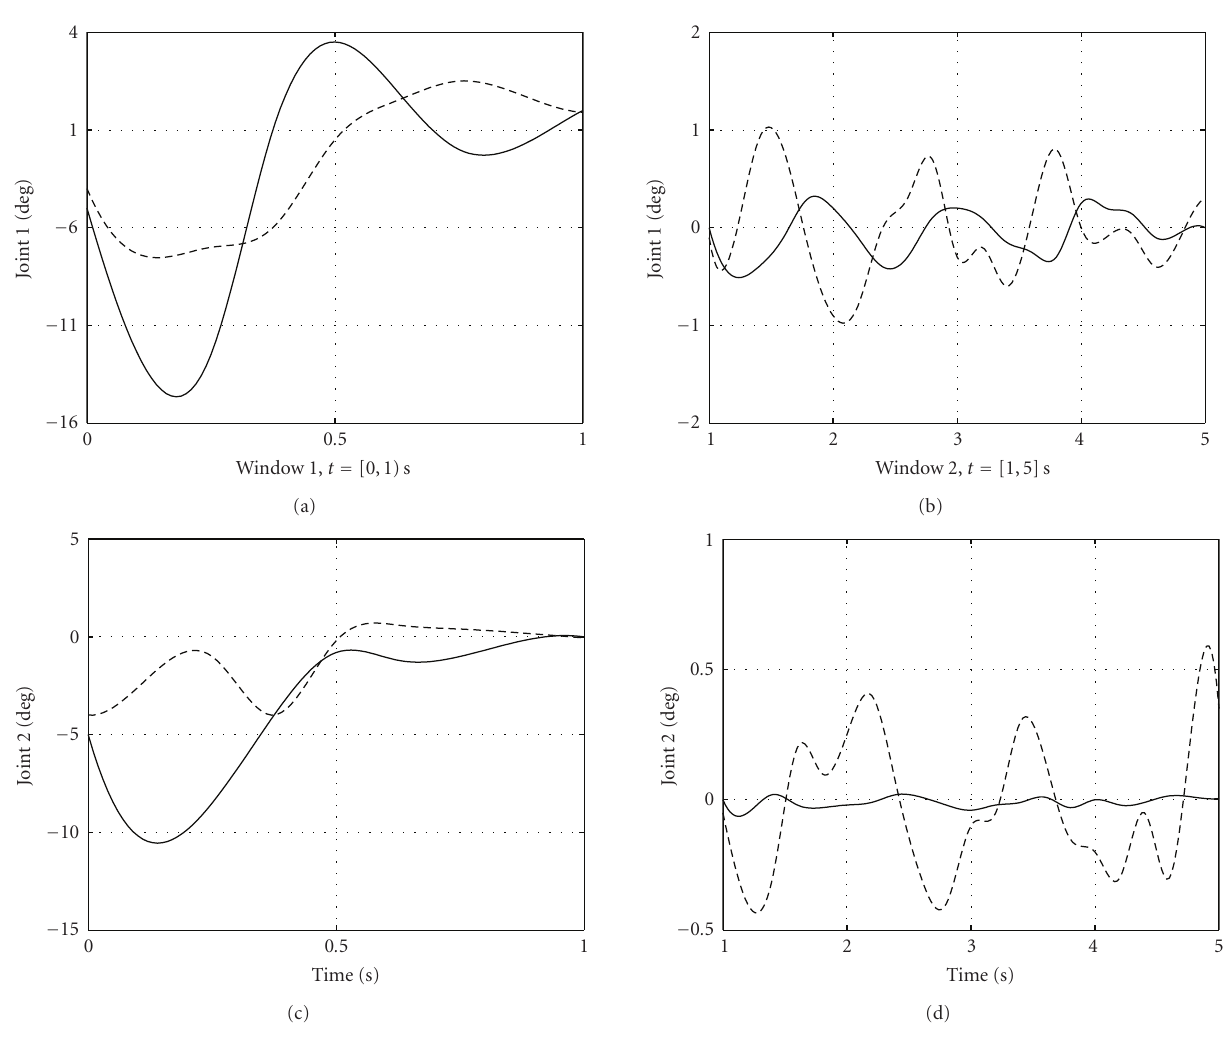
known, we have the following simulation results as shown in Figure 2 ( α = 10) and Figure 3 ( α = 100), by the choose of the upper bound function as N ( t ) = 20 + 7 . 5 (cid:4) E (cid:4) + 5 . 0 (cid:4) E (cid:4) 2 .